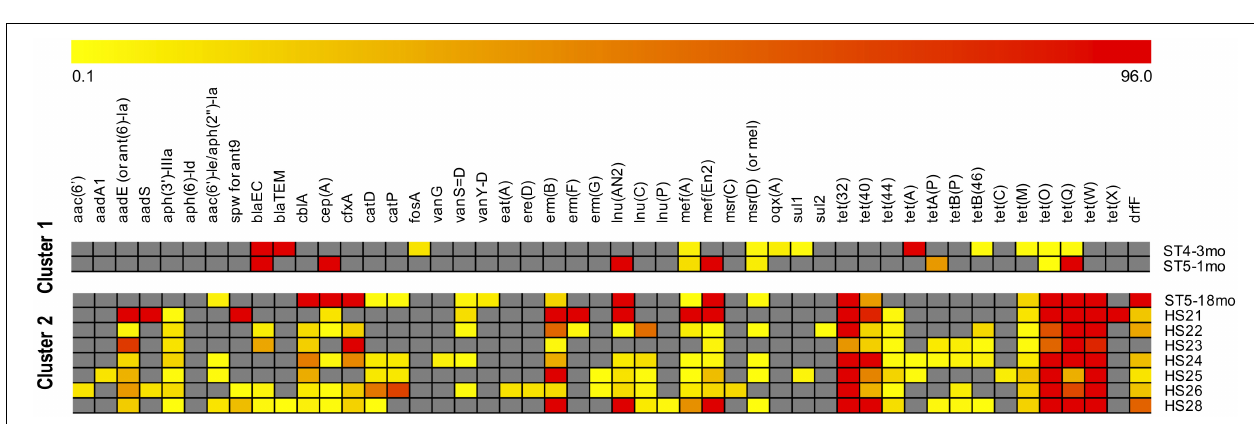
FIGURE 4 | Clustering of samples by antimicrobial resistances genes (ARGs) abundance. ARGs were identified with the SMS + BLAST analysis. The samples identifiers are indicated on the right side (ST are infants, HS are adults). The “mean base depth per 5 million reads” (BD5M) calculated for each ARG in each sample was used as an input for the k -means clustering (1,000 maximum iterations, 50 runs). The color scale is: gray when the gene is absent; from light yellow to dark red with increasing gene abundances (BD5M 0.1–96), with values adjusted to log2. To avoid one outlier effect [gene tet(A) in ST4-3mo; BD5M = 279.8] the maximum value was set as the second highest abundance [gene tet(X) in HS24; BD5M =